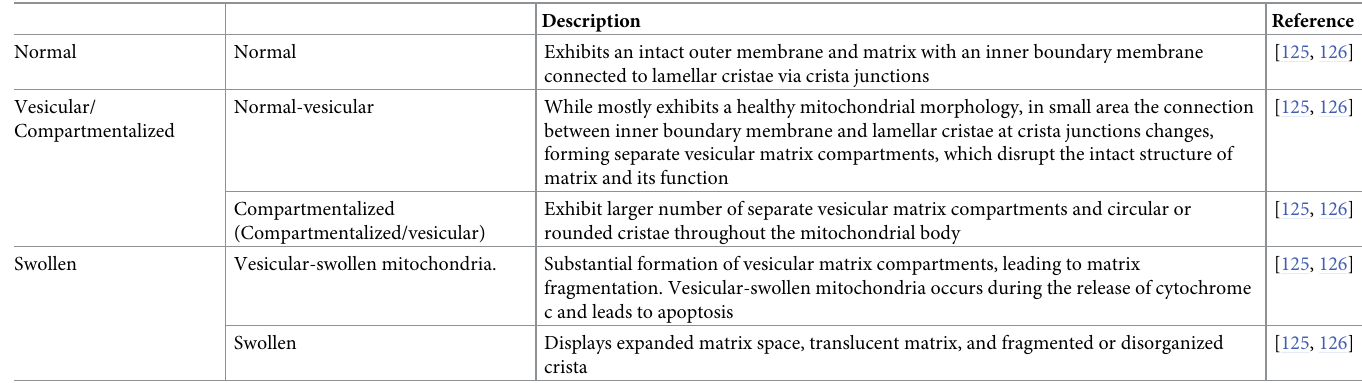
Table 5. TEM-based morphological characteristics of mitochondria with normal or abnormal ultrastructural appearance.